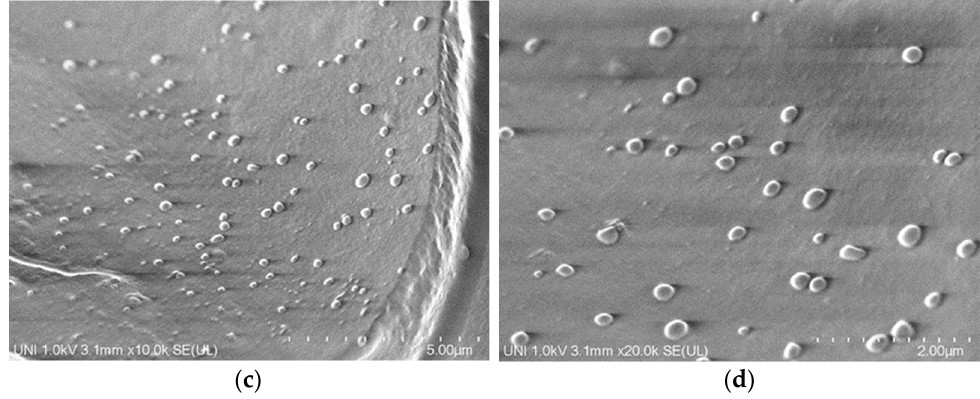
Figure 6. Scanning electron microscope (SEM) micrographs of CSNP at ( a ) 1000× magnification and ( b ) 20,000× magnification, and the optimized CEO-CSNPs at ( c ) 1000× magnification and ( d ) 20,000× magnification.